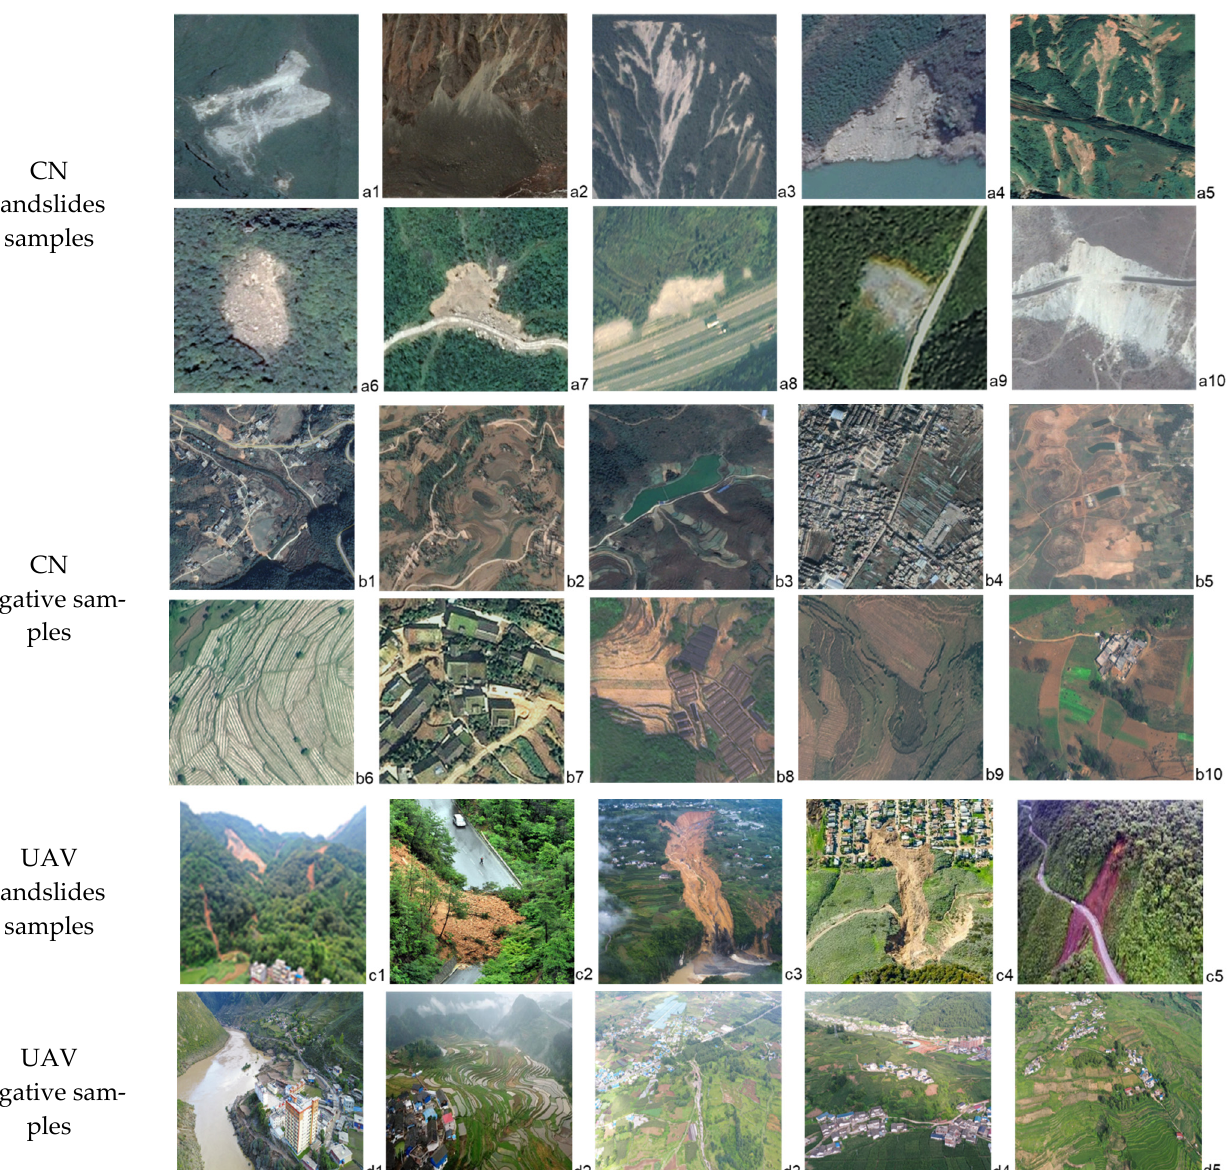
Figure 3. The research sample for this paper. The landslide samples contain one or more landslides per image, and the negative samples are environmental images that do not contain landslides.